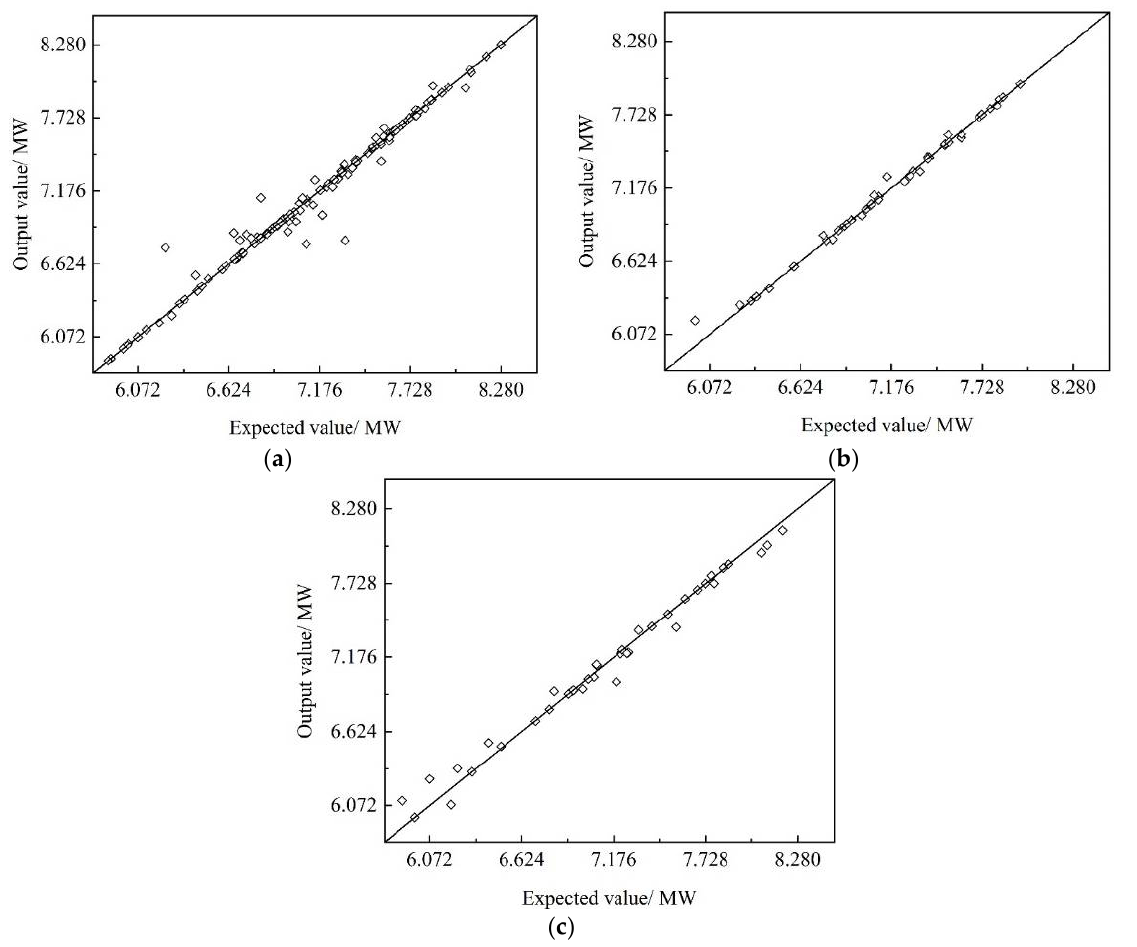
Figure 8. Comparison between the expected value and the true value of RBFNN. ( a ) Training stage; ( b ) validation stage; ( c ) testing stage.